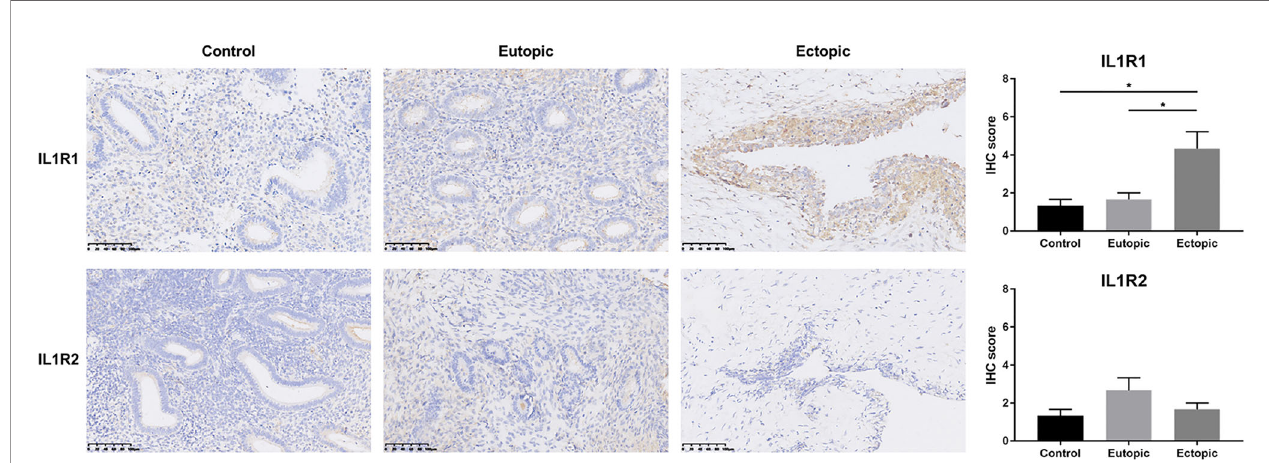
FIGURE 5 | IL1R1 was over-expressed in ectopic endometrium. Representative photomicrographs of immunostaining with IL1R1 and IL1R2 in endometriotic lesions and eutopic endometrium from women with or without endometriosis. Scale bars = 100 m m. Immunostaining scores are represented as mean ± SEM. Statistical comparisons were carried out with Kruskal-Wallis test followed by Dunn ’ s multiple comparison test. * P <